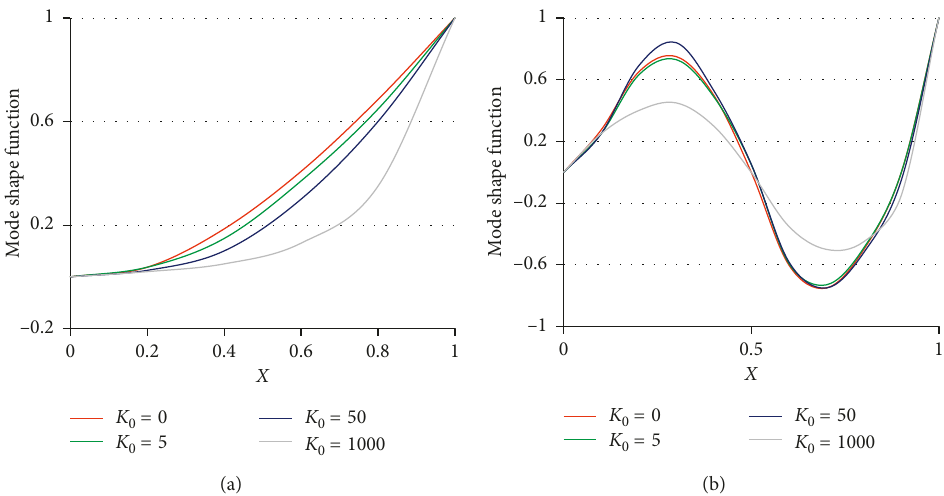
Figure 4: (a) First and (b) third mode shapes for various stiffness parameters with P �